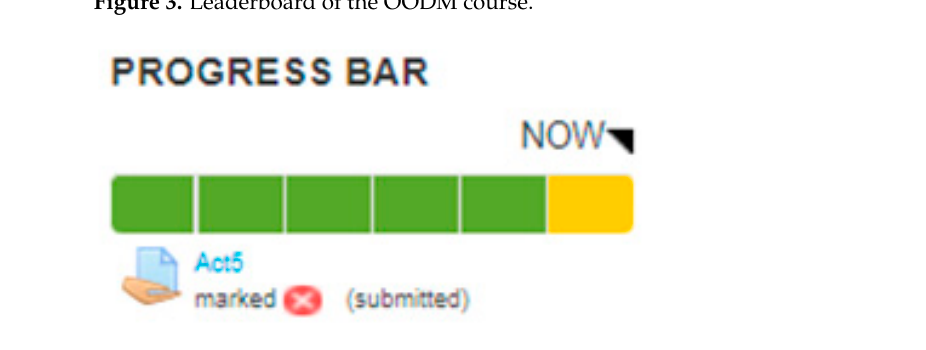
Figure 4. Progress bar of OODM course.